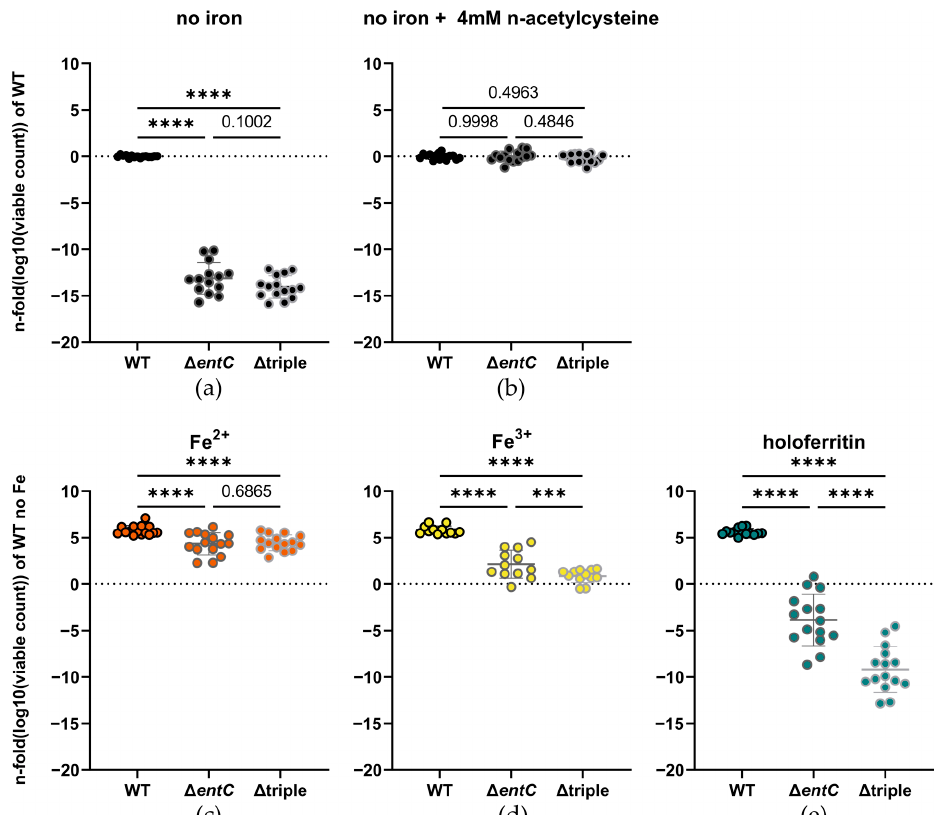
Figure 2. S. Tm ATCC 14028 and derivative knockout mutant strains were grown ( a ) without any supplement (N = 15, n = 5) or ( b ) with the addition of 4mM of n-acetylcysteine (N = 15, n = 5). Growth of the same strains with 5 µM ( c ) of ferrous iron (N = 15, n = 5), ( d ) of ferric iron (N = 12, n = 5) or ( e ) of ferritin-bound iron as sole iron source (N = 15, n = 5). Growth data were logarithmized and then normalized to the WT without any iron supplement. Graphs are depicted as mean ± SD. For statis- tical analysis ( a – e ) one-way ANOVA corrected for multiple comparisons with the Holm-Sidak post hoc test was used (***: p < 0.001, ****: p < 0.0001, numbers indicate a non-significant p -value > 0.05). N: number of biological replicates, n: number of experiments conducted, WT: wildtype, Δ entC : S. Tm enterobactin/salmochelin knockout mutant strain, Δ triple: combined knockout mutant strain of entC , sit and feo .